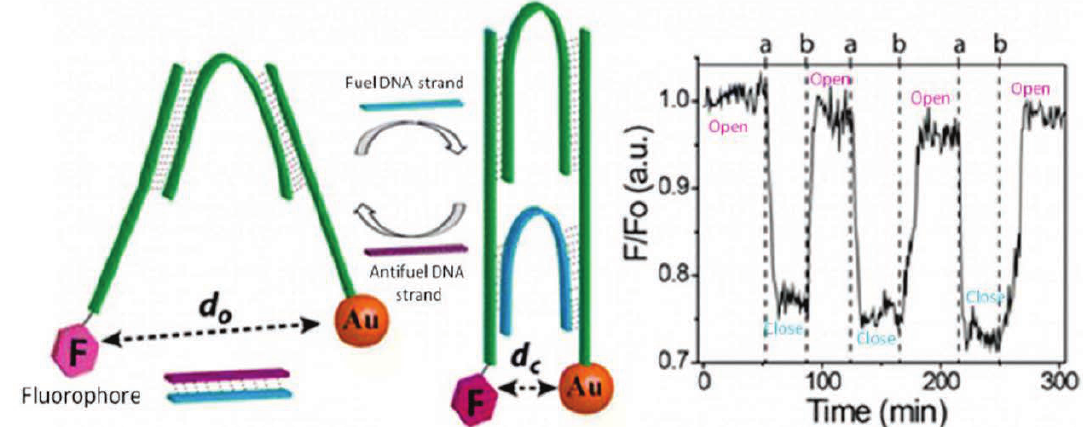
Figure 8. Mechanical control of the fluorescence properties of different fluorophore/Au NP-functionalized tweezers through the cyclic opening and closure of the tweezers by means of fuel/antifuel DNA strands. Reprinted with permission from [54]. Copyright 2013 American Chemical Society [54].